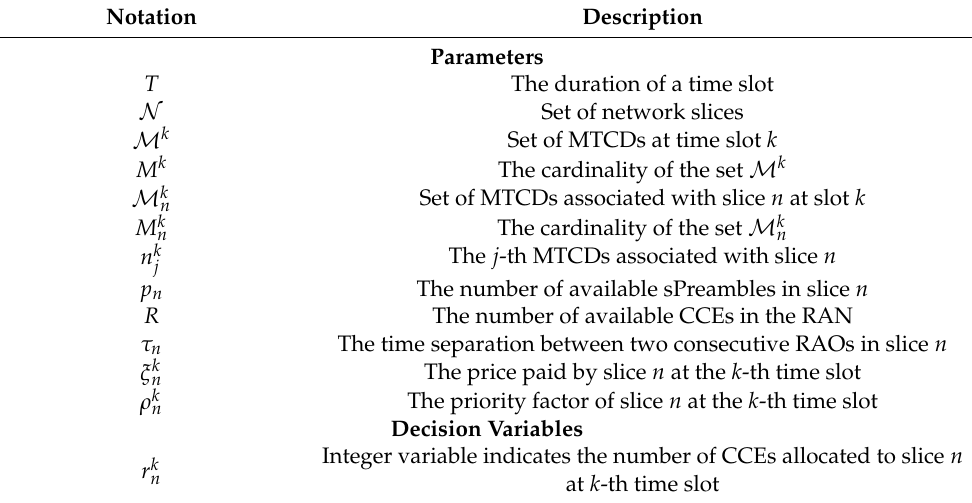
Table 1. Summary of